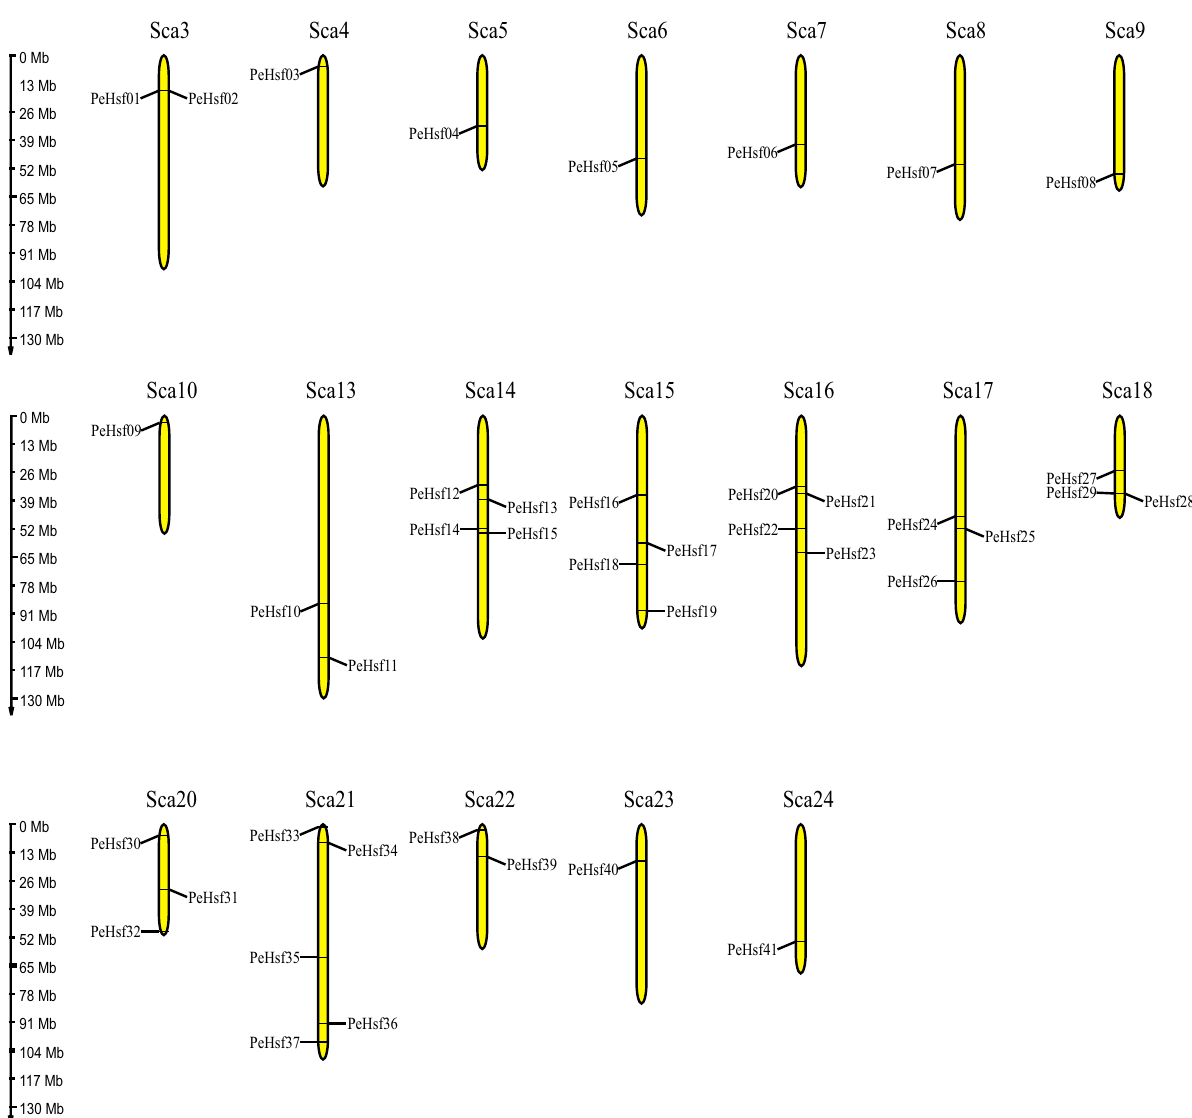
Figure 6. The distribution of PeHsf genes on the moso bamboo chromosome scaffolds. MG2C v.2 (http:// mg2c. iask. in/ mg2c_ v2.0/) was used to visualize the gene locations on